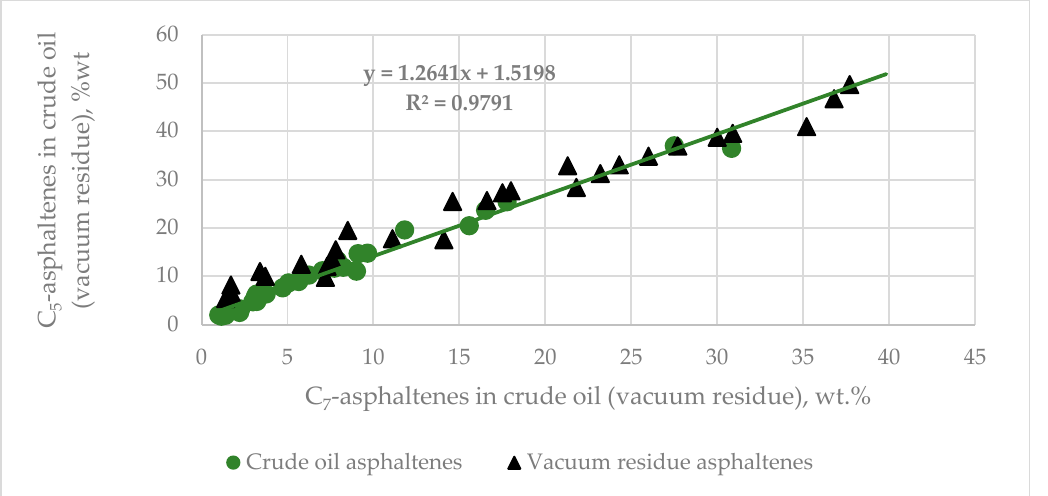
Figure 4. Relation of C 7 - to C 5 -asphaltenes in crude oils and in their vacuum residue fractions.